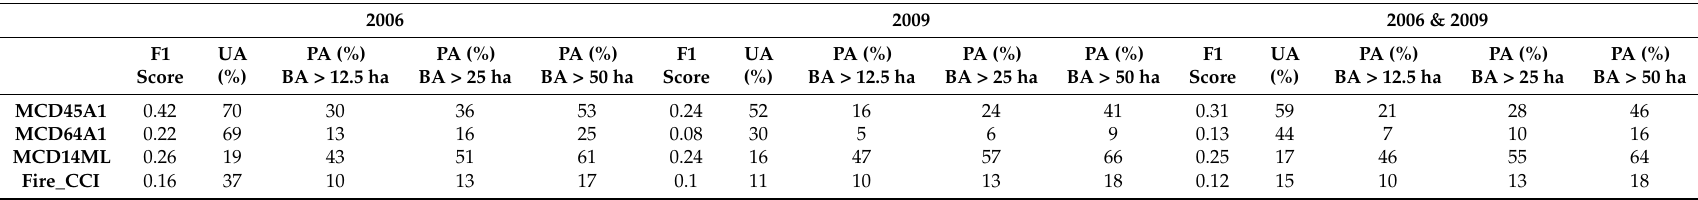
Table 2. Performances of MCD45A1, MCD64A1, MCD14ML, and Fire_CCI products in a control site in northwest Yunnan for the year 2006, 2009, and 2006 & 2009 combined. F1 score and user’s accuracy (UA) are shown for burned areas (BA) > 12.5 ha (full dataset) only, while producer’s accuracy (PA) is shown for BA > 12.5 ha, > 25 ha, and > 50 ha.